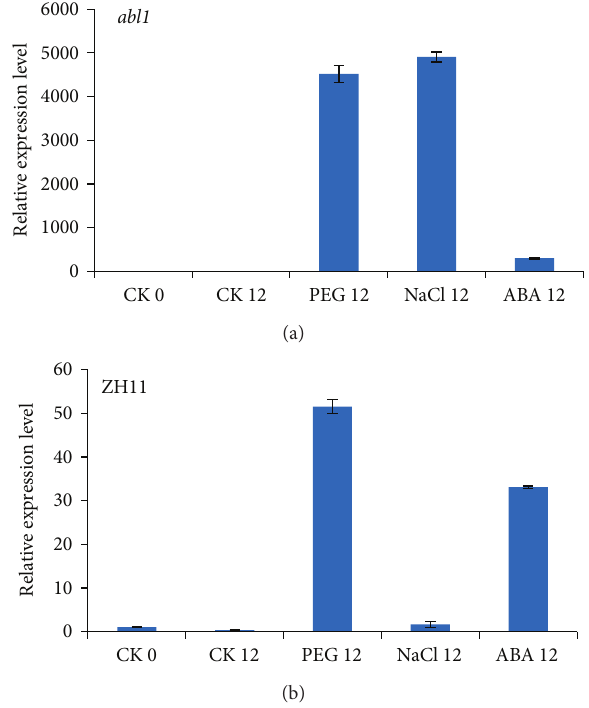
Figure 8: Expression change of OsSLI1 in rice abl1 mutant (a) and WT ZH11 (b) seedlings under different